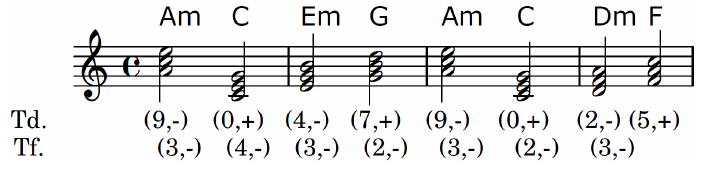
Figure 4. Output progression, high µ 1 .